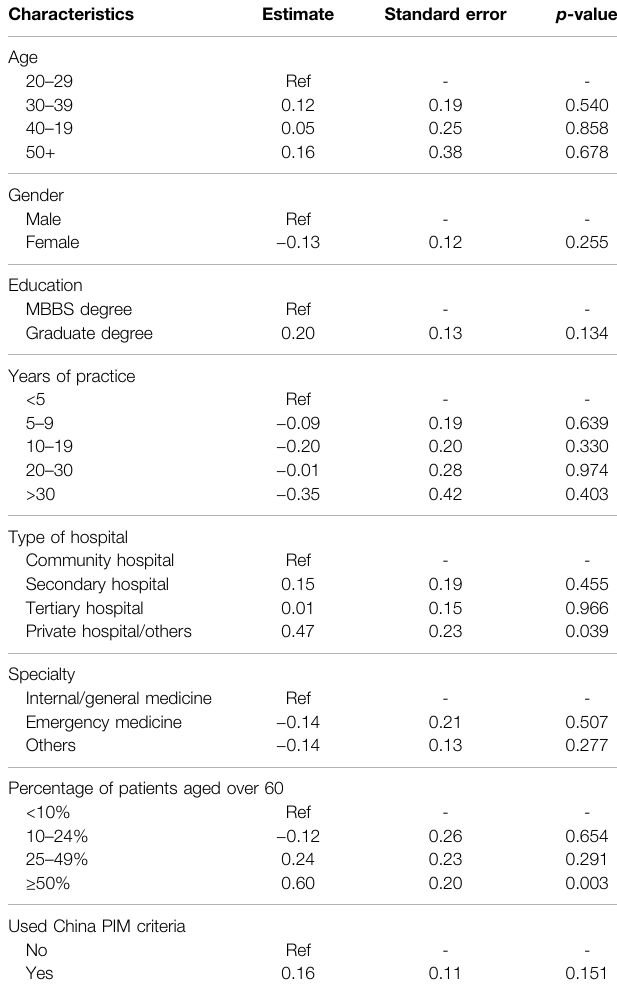
TABLE4| Factorsassociatedwiththeknowledgelevelofpotentiallyinappropriate medication.